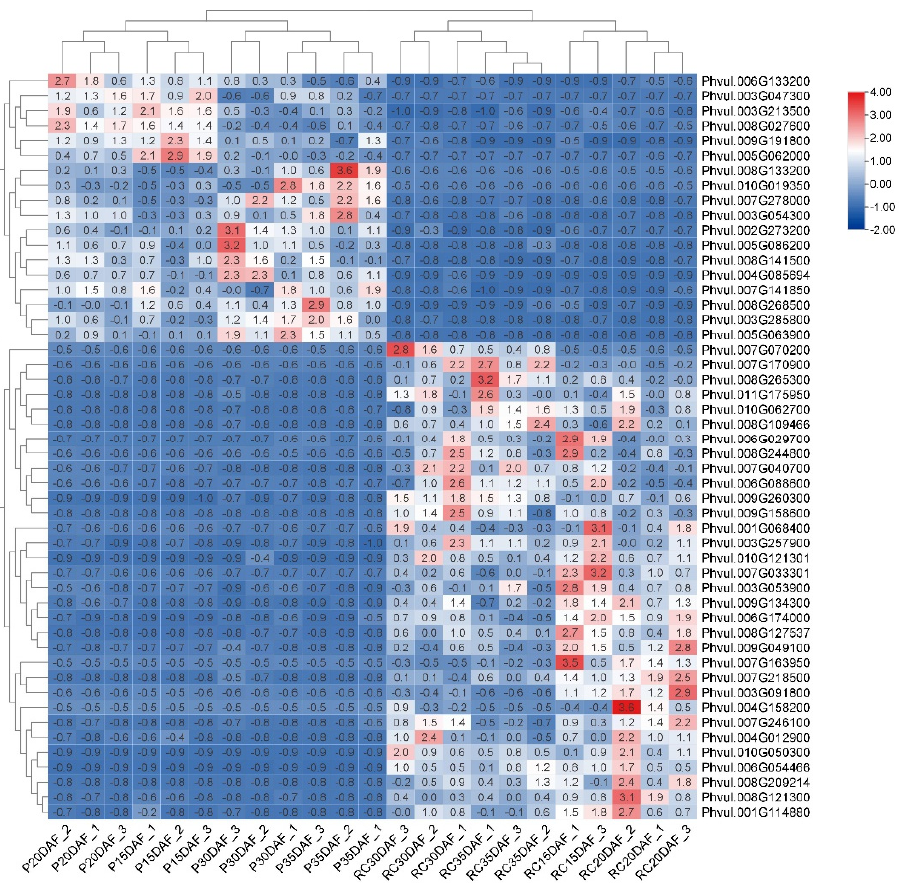
Figure 9. Heat map showing the expression patterns of top 50 DEGs identified between slow-cooking (Pinto) and fast-cooking (Rosecoco) common bean varieties. The gene-expression values used to construct the heat map were normalized using the counts per million (CPM) normalization method, and were further transformed into a logarithmic scale (shown within each cell). Normalized scaling was applied to rows, and the intensity of colour associated with DEGs ranges from red (upregulated genes) to blue (downregulated genes). The gene identifiers (IDs) are shown on the right side of the figure. Significant DEGs with an FDR value of <0.05 were selected to construct the heat map. Average clustering was performed between the rows and columns using Euclidean